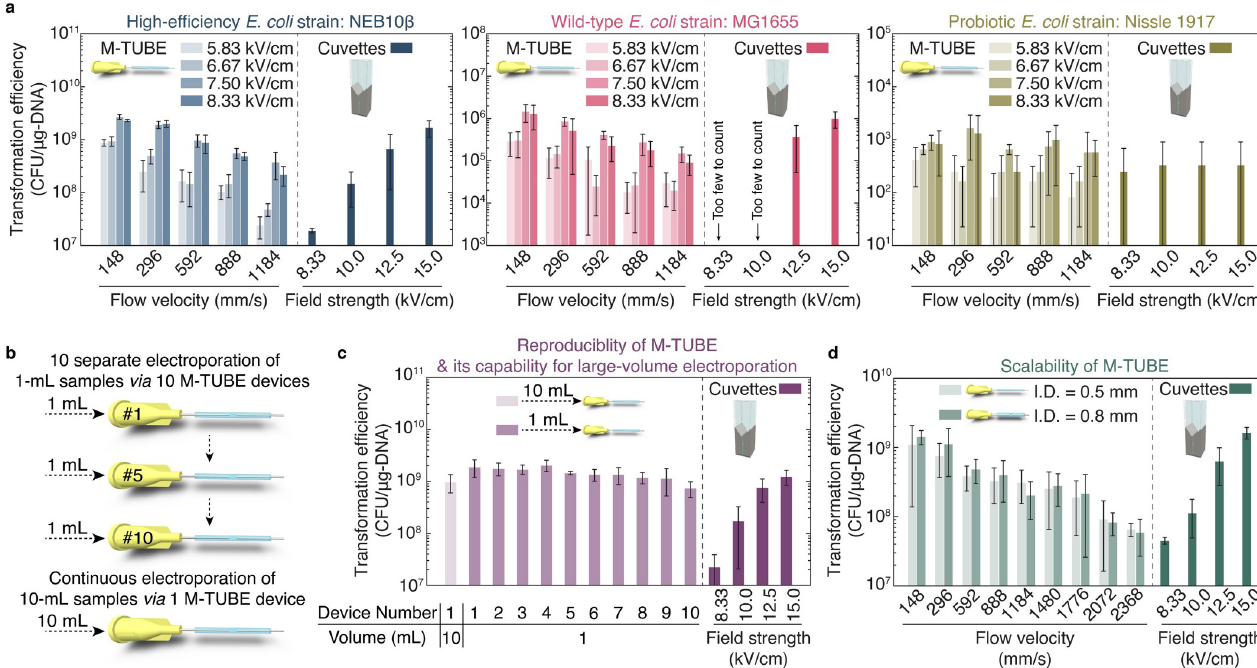
Fig 2. The M-TUBE device exhibits higher efficiency than cuvettes across E . coli strains, is reproducible, and maintains high efficiency across tubing sizes. (a) Comparison of M-TUBE device performance when transforming the high-efficiency strain NEB10 β , the wild-type strain MG1655, and the probiotic strain Nissle 1917 across voltages and fluid velocities. M-TUBE outperformed cuvettes at an equivalent electric field strength for all strains. Data represent the average ( n � 3) and error bars represent 1 standard deviation. (b) Schematic of the experiment comparing 10 separate 1 mL electroporations and 1 continuous electroporation of a 10-mL sample. (c) Transformation efficiency for the experiments in (b) demonstrates that sample volume can be increased without compromising efficiency. Data represent the average ( n � 3) and error bars represent 1 standard deviation. The same batch of cells was used to conduct cuvette-based electroporation as a comparison. (d) Transformation efficiency was similar across 0.5-mm and 0.8-mm diameter M-TUBE devices. For M-TUBE devices, a voltage of ± 2.50 kV (AC field) was applied, which results in an electric field of 8.33 kV/cm. Data represent the average ( n � 3) and error bars represent 1 standard deviation. The data underlying this figure can be found in S2 Data. AC, alternating current; M-TUBE, microfluidic tubing-based bacterial